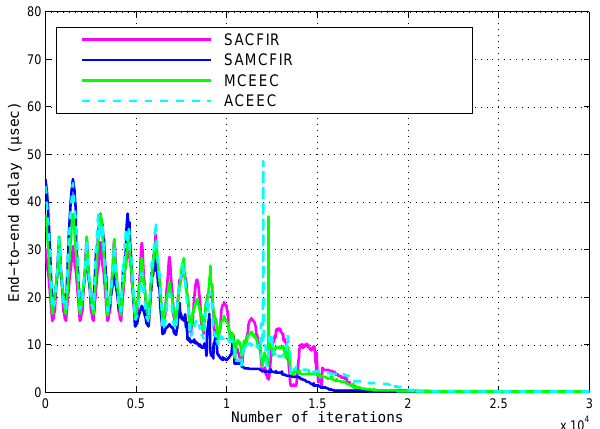
Figure 17. End-to-End delay experienced by execution of compared protocols.